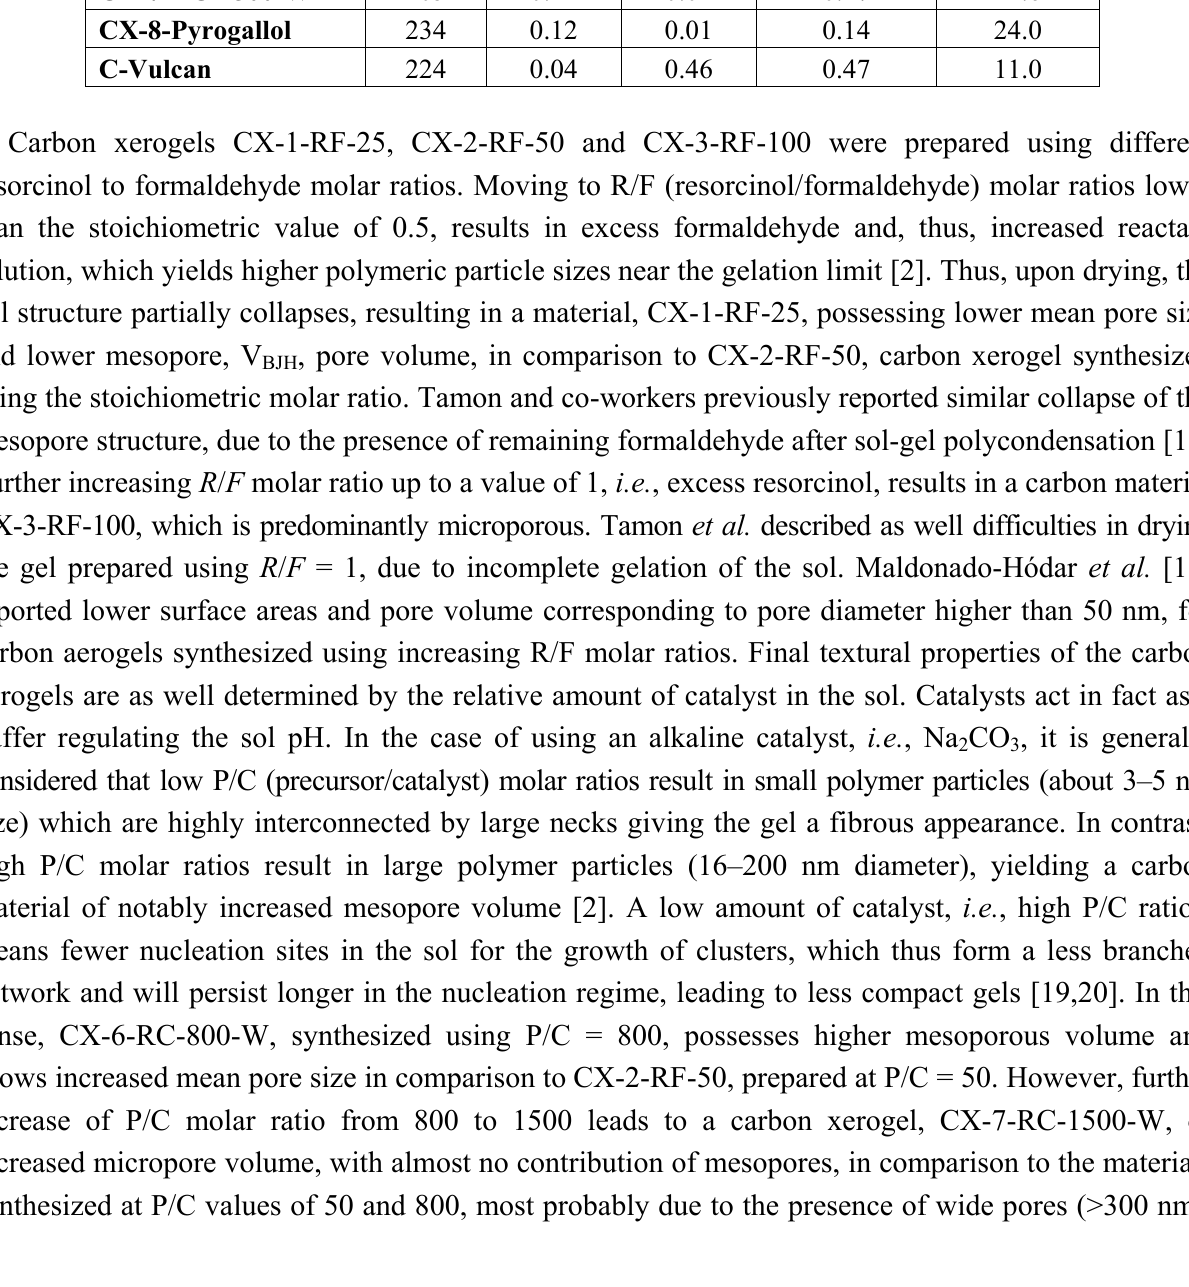
adsorption isotherms for the 2